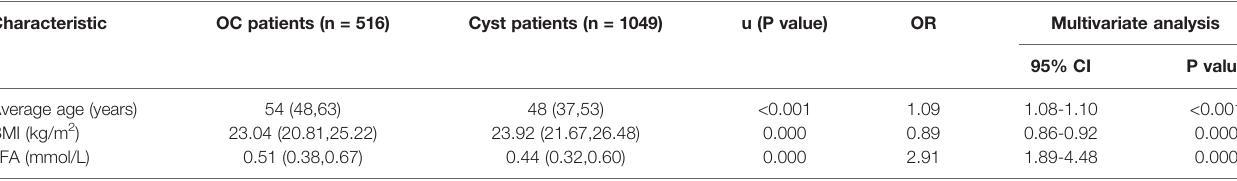
TABLE 1 | Comparison of patients with OC and benign ovarian tumors.